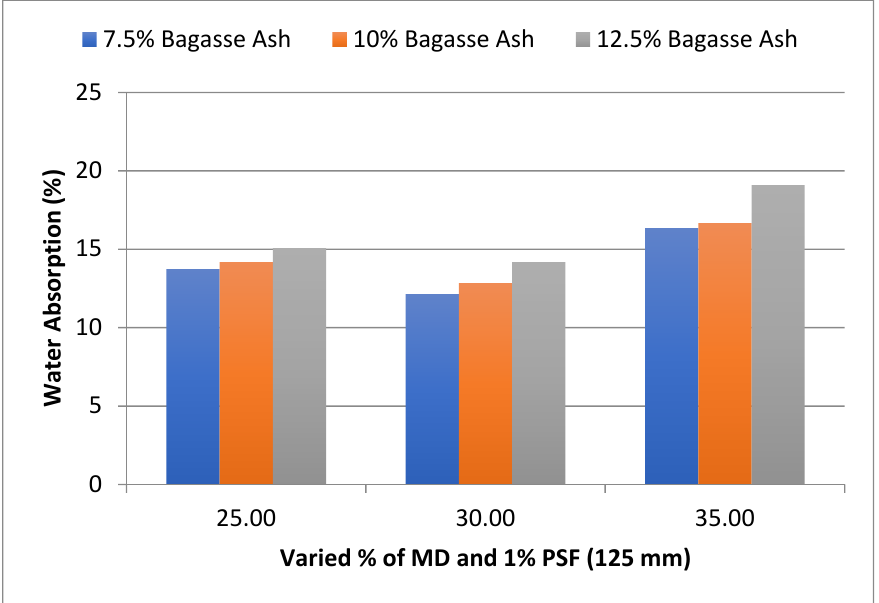
Figure 9. Effect of MD and BA on water absorption of block reinforced with 1% PS fiber (125 mm).